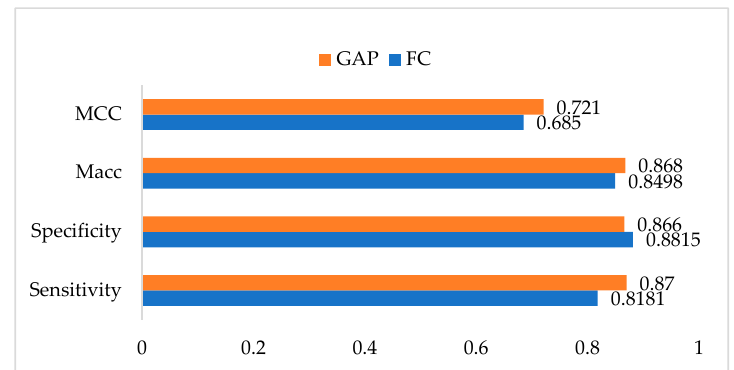
Figure 4. Performance comparison between the fully connected layer and the global average pooling layer. FC, fully connected layer.